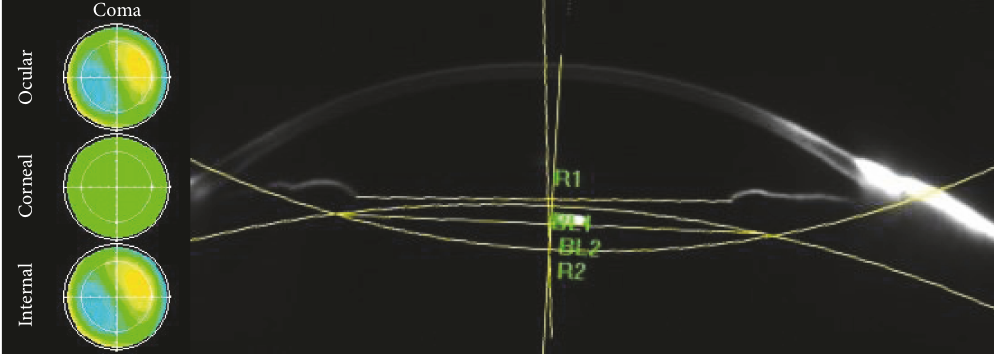
Figure 3: Illustration of the coma aberrations and measurements of tilt and decentration in a Scheimp fl ug image of a typical patient from the open-globe-injury group. Horizontal tilt was 2.85 ° and horizontal decentration was 0.50mm; vertical tilt was 1.5 ° and vertical decentration was 0.47 mm. Internal coma is a major source of ocular